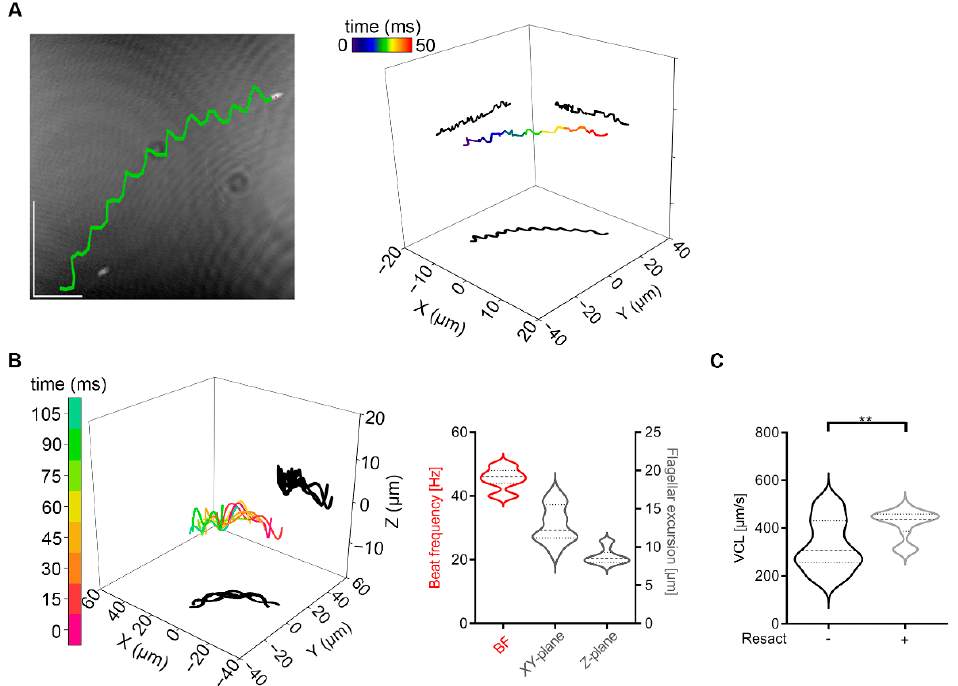
Figure 4. 4D motility analyses of sea urchin sperm. ( A ) 50 ms swimming path of a sea urchin sperm overlaid on the reconstructed XY projection of the final frame in the 0.5 s holographic record (63X objective) (left) and illustrated in 4D (right). The swimming trajectory is visualized by tracing the head position. ( B ) 4D flagellar waveform analysis whereas the time-lapse trace of a flagellum at 3D position (laboratory-fixed frame of reference xyz) is visualized in color and its projections onto XY - and XZ -planes are shadowed in black (left). Statistical analysis of beat frequency and flagellar XY - and Z -excursion (right). ( C ) Statistical analysis of curvilinear velocity. N = 3, n = 15, median: thick dashed lines; interquartile range: thin dashed lines. ** p <